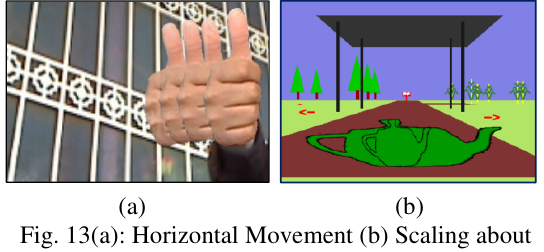
Fig. 15: A User Performs Interaction by Dynamic Movement of